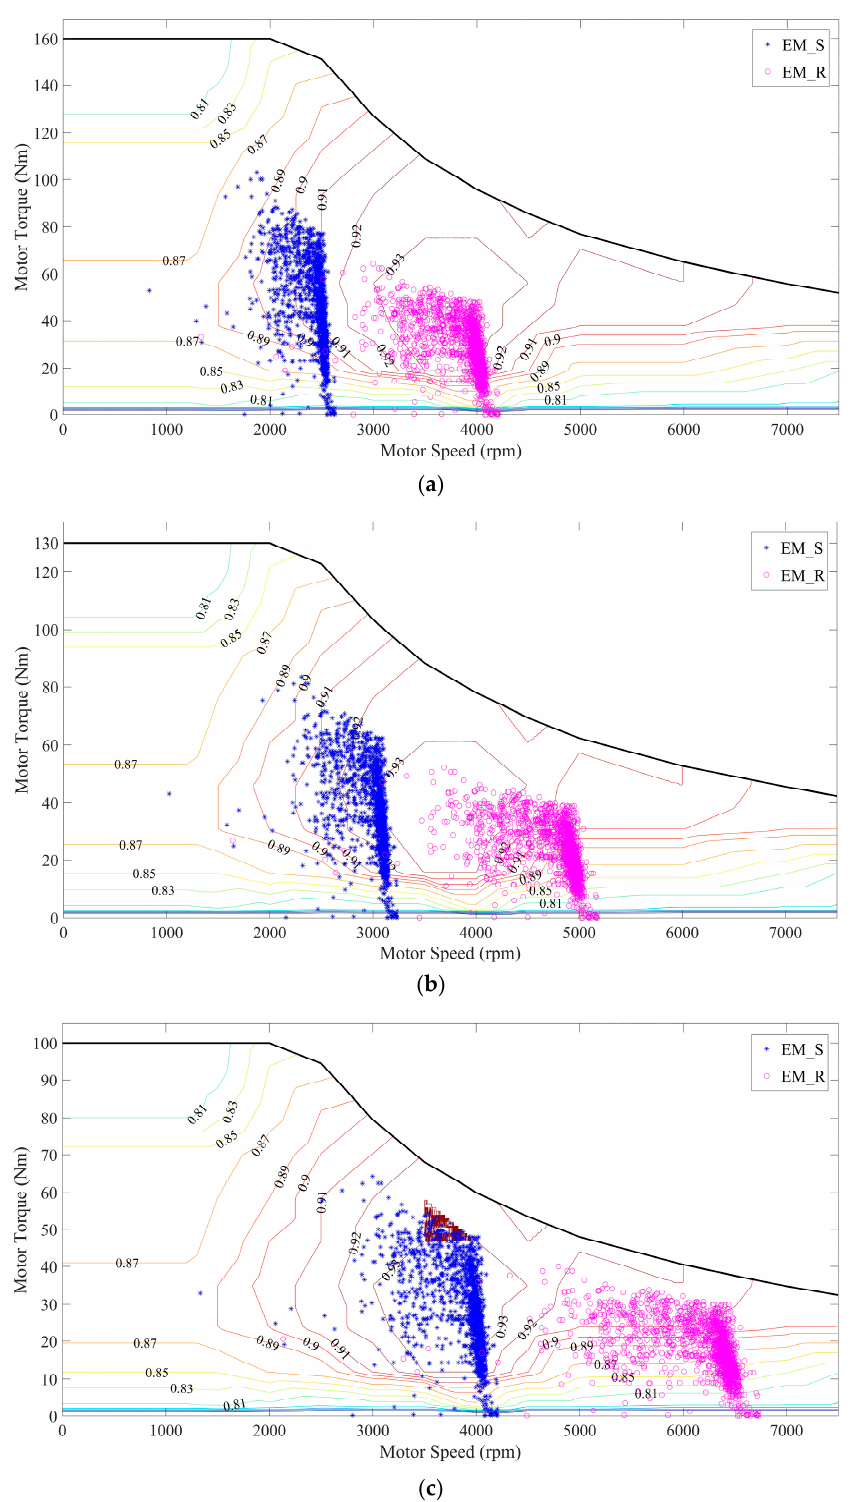
Figure 16. Working points of power take ‐ off (PTO) motor with different PDR. ( a ) PDR = 0.8 or 0.2; ( b ) PDR = 0.65 or 0.35; ( c ) PDR = 0. 5.